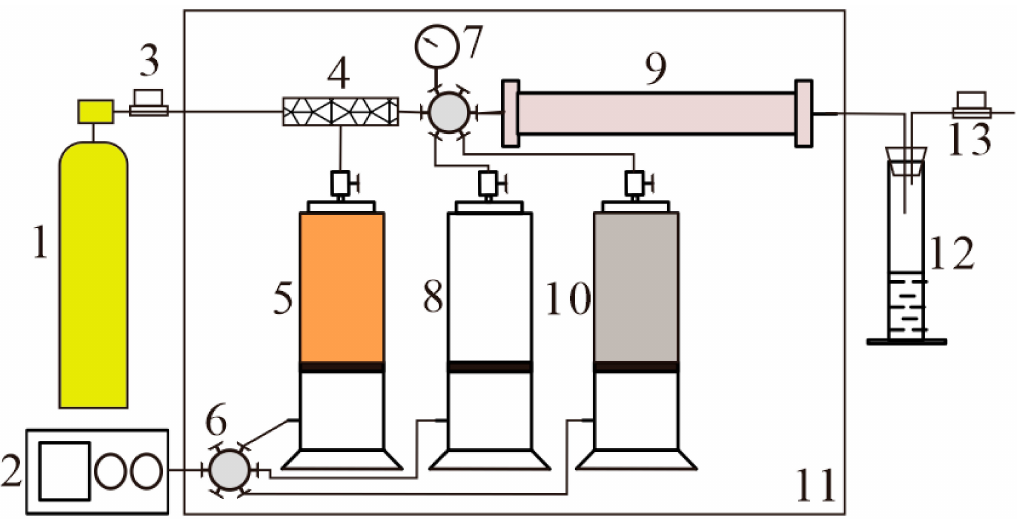
Figure 2. The experimental flow chart: 1—nitrogen; 2—constant-flux pump; 3—mass-flow gas meter; 4—foam generator; 5—gelling fluid; 6–valve; 7—pressure meter; 8—brine; 9—sand pack; 10—crude oil; 11—oven; 12—burette; 13—gas flow